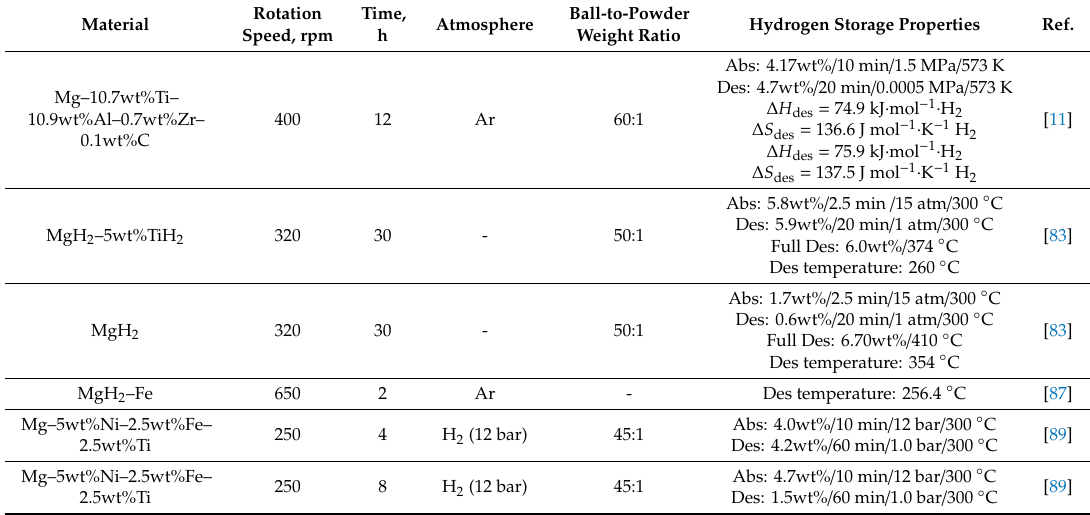
Table 2. Hydrogen storage properties of selected Mg modified by transition metal additives.